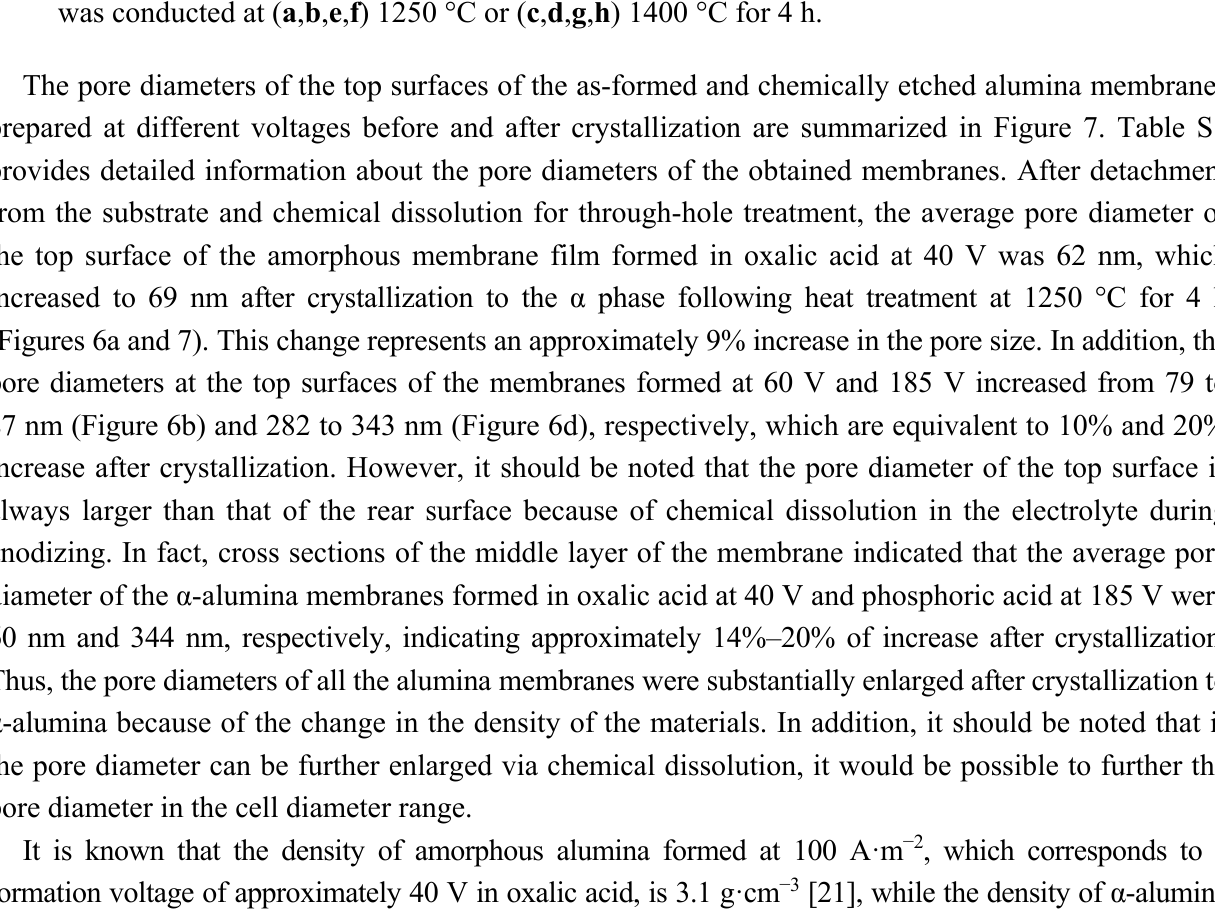
Figure 6. SEM images of the ( a – d ) top and ( e – h ) rear surfaces of the α -alumina membranes formed at ( a , e ) 40 V, ( b , f ) 60 V, ( c , g ) 100 V, and ( d , h ) 185 V. Heat